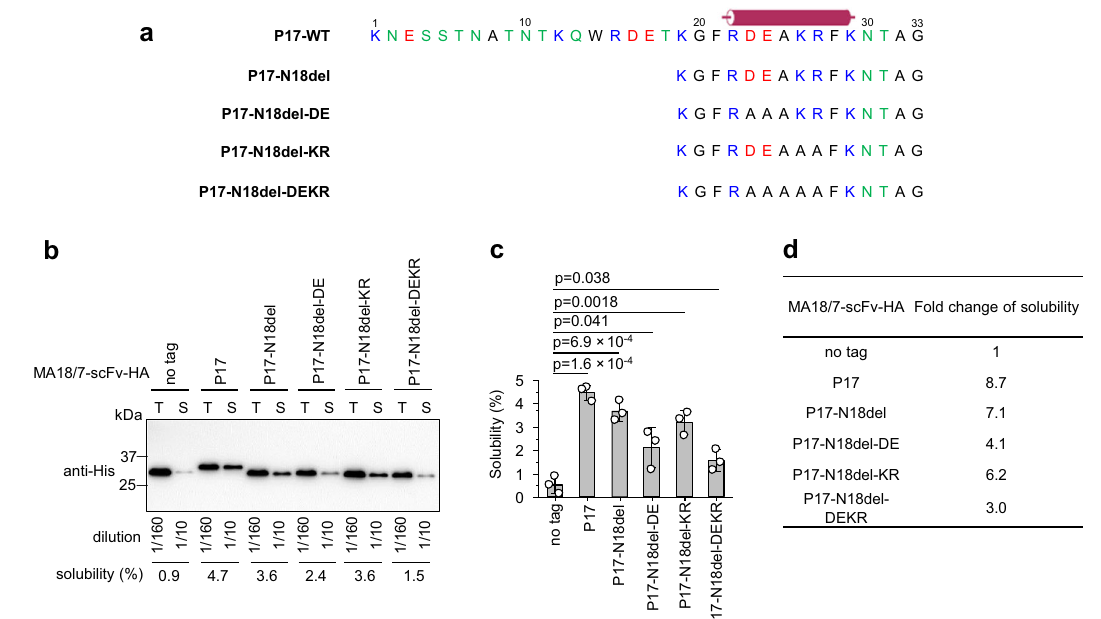
Fig. 7 | Alanine substitution of basic and acidic residues reduced solubility- enhancing ability of the P17-N18del tag. a Amino acid sequences of wt P17 tag (P17-WT), truncated mutant P17-N18del and its point mutants P17-N18del-DE, P17- N18del-KR, and P17-N18del-DEKR. In these mutants, acidic residues (D23 and E24) andbasicresidues(K26andR27)werereplacedaloneorincombinationbyalanine (A).Basic,acidic,andpolarresiduesareshowninblue,red,andgreen,respectively. Residues 22 – 29 of P17 tag predicted to form α -helix are denoted with a cylinder. b Representative western blot to determine the solubility of MA18/7-scFv-HA